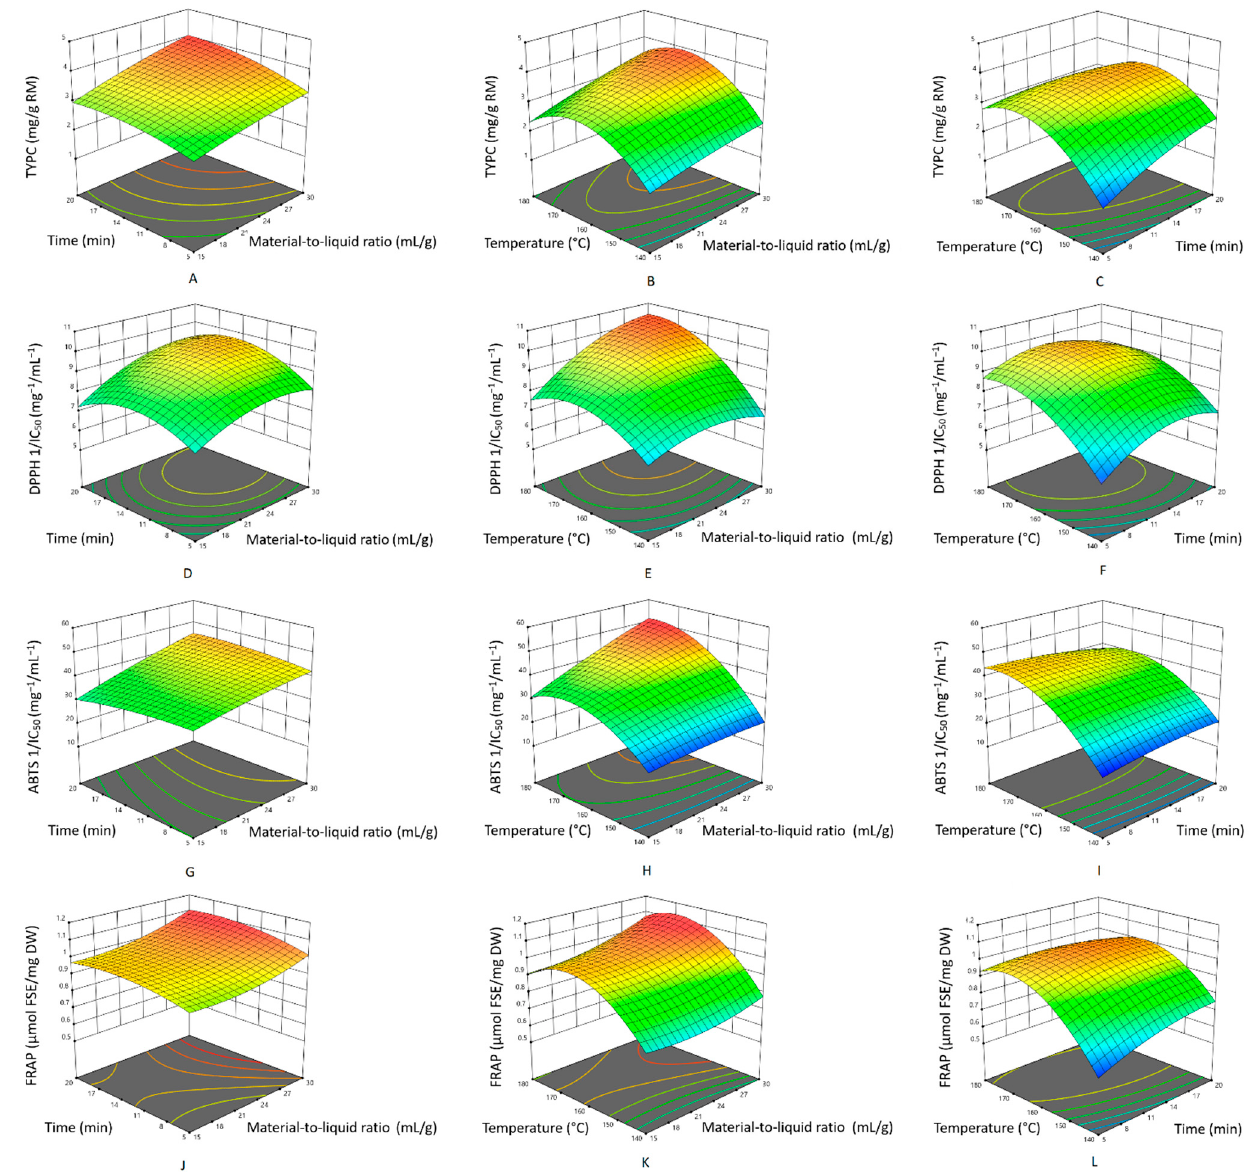
Figure 4. Response surface plots for the yield of the total target phenolic compounds ( A – C ) and antioxidant capacity measured by the DPPH ( D – F ), ABTS ( G – I ), and FRAP methods ( J – L ) as a function of the investigated factors.